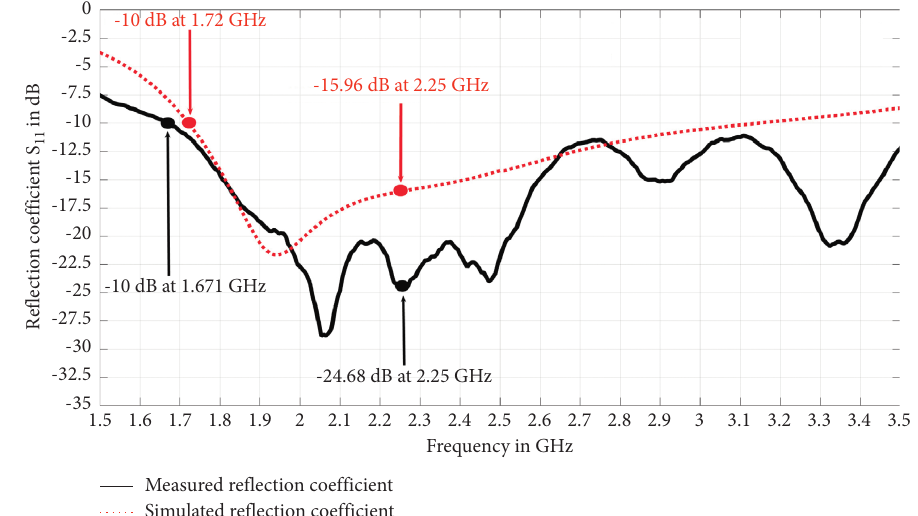
Figure 12: Simulated and measured reflection coefficient for the optimized antenna from 1.5 to 3.5.